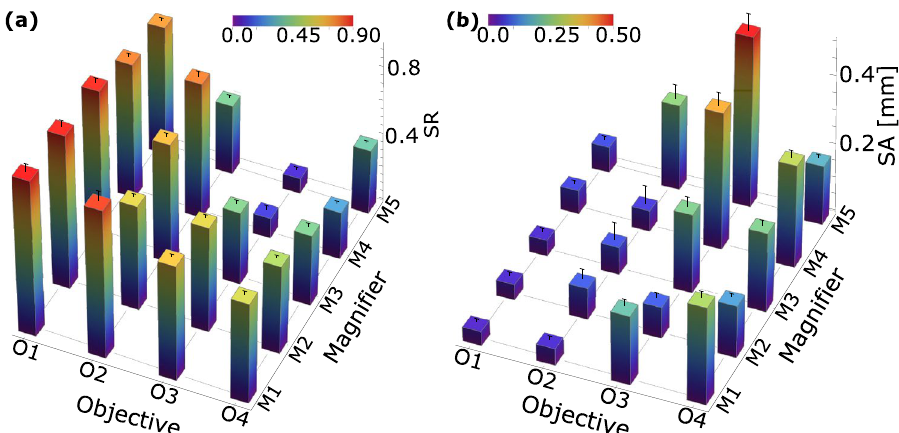
Figure 2. ( a ) Strehl ratio (SR) and ( b ) spherical aberration (SA) for all possible combinations of objectives (O1– O4) and magnifiers (M1–M5) those we have